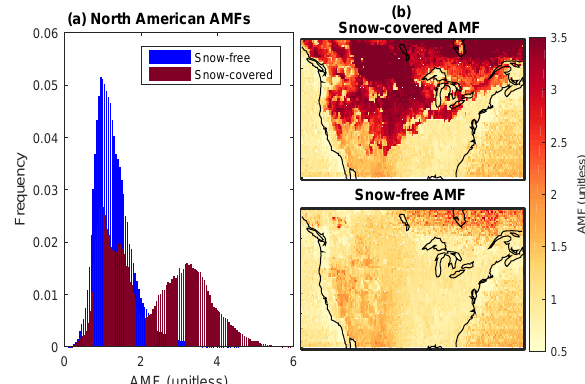
Figure 3. (a) Distribution of air mass factors (AMFs) calculated for OMI NO 2 retrievals over North America for observation geometry of January 2013, using snow-free (Sun et al., 2017) or snow-covered (O’Byrne et al., 2010) surface reflectance. (b) Maps of AMF for snow-covered and snow-free